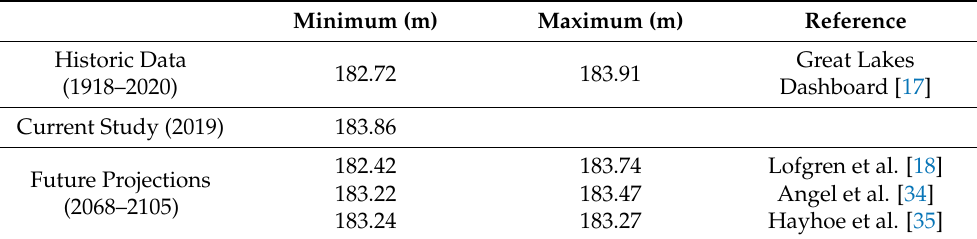
Figure 2. Process of bathymetric analysis of Lake Superior at three study sites in the Keweenaw Peninsula, Michigan. Topo bathymetry data (4 m) was used to characterize the general structure of the lake bottom at each study site, Brunette Park, Hunter’s Point and McLain State Park ( left ). At each study site, an autonomous underwater vehicle (AUV) was pre-programmed to collect multibeam XYZ data, which was used to create high-resolution (0.3 m) maps of microtopography at each study site. Three 400 m 2 plots were established to quantify the structure of surface irregularities of the substrate for periphyton habitat ( right ). Table 1. Historic and future Lake Superior water levels (m) along with the water level of the current study (sample collection at z = 0) [17] for